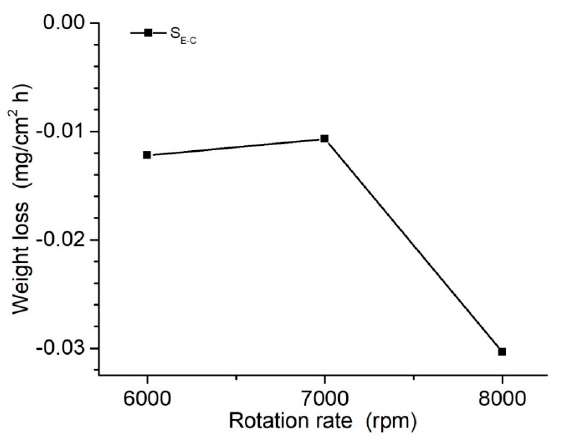
Figure 9. Synergy effect ( S E-C ) for AISI 304L stainless steel determined by using Equation (1). Figure 9. Synergy e ff ect ( S E-C ) for AISI 304L stainless steel determined by using Equation (1).